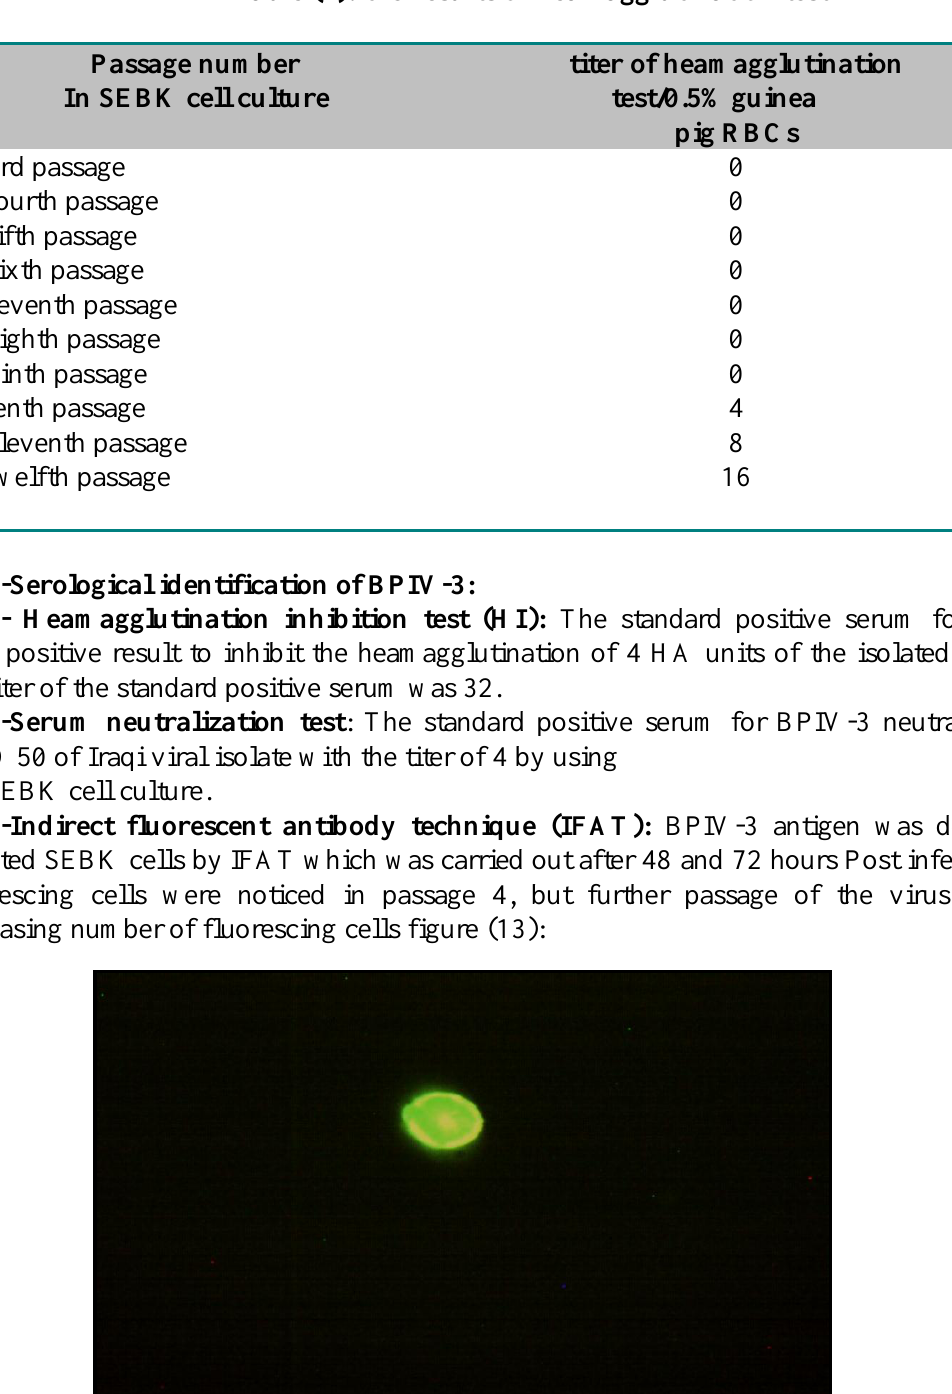
Table (2): the results of heamagglutination test